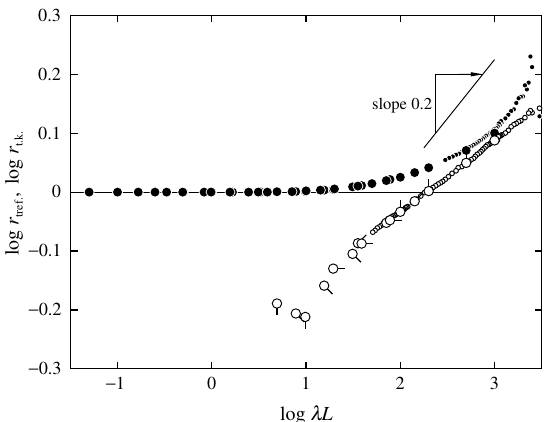
Figure 3. Double-logarithmic plots of r tref. and r t.k. against λ L . The large open circles represent the MC values of r tref. for the discrete KP ring, various directions of the pip having the same meaning as those in Figure 1. The small open circles represent the MC values of r tref. for the freely jointed ring obtained by Moore et al. [20]. The large and small closed circles represent the MC data of r t.k. for the discrete KP ring obtained in the previous study [7] and those for the freely jointed ring obtained by Moore et al. [20],